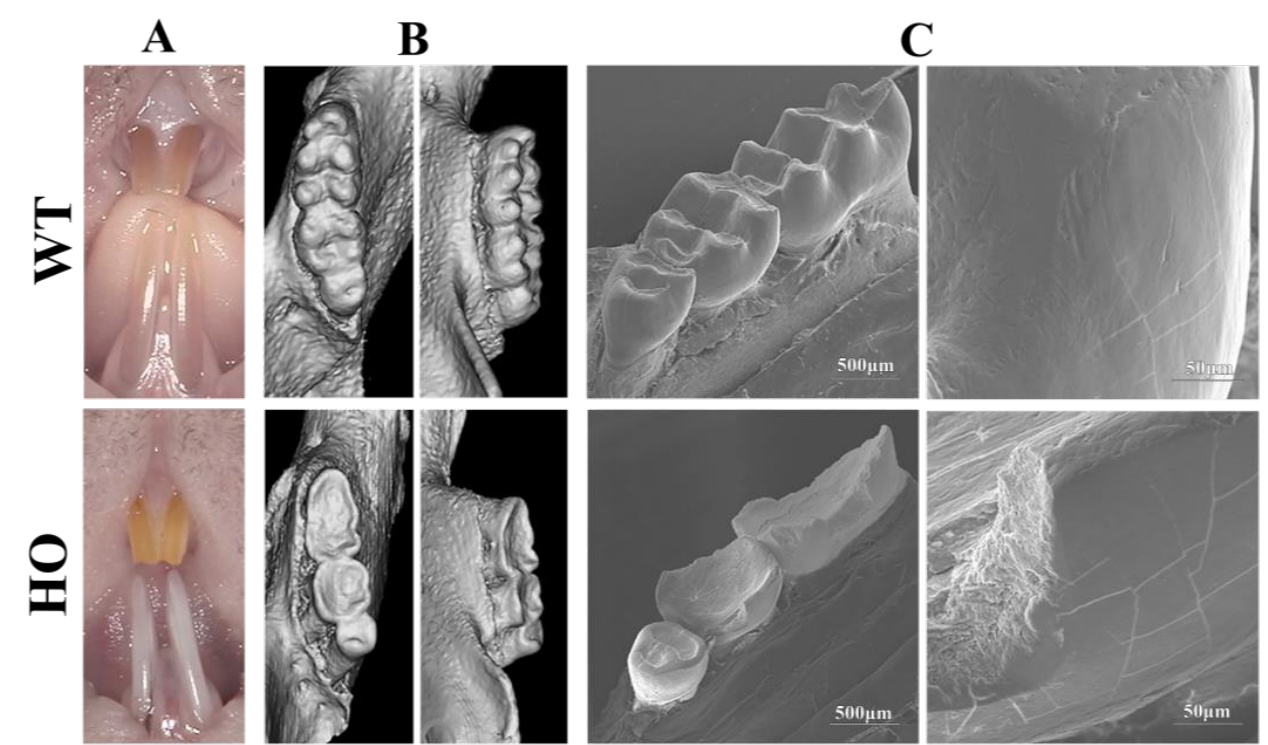
Figure 3. Teeth from HO mice showed severe enamel structure defects: ( A ) incisors of the HO mice looked chalky and thin compared to normal incisors; ( B ) representative CT reconstruction on the occlusal and axial plane of defleshed mandibles demonstrated complete cusps in WT mice molars but a concave surface in HO mice molars; ( C ) SEM presented that HO mice teeth appeared rough and incomplete.